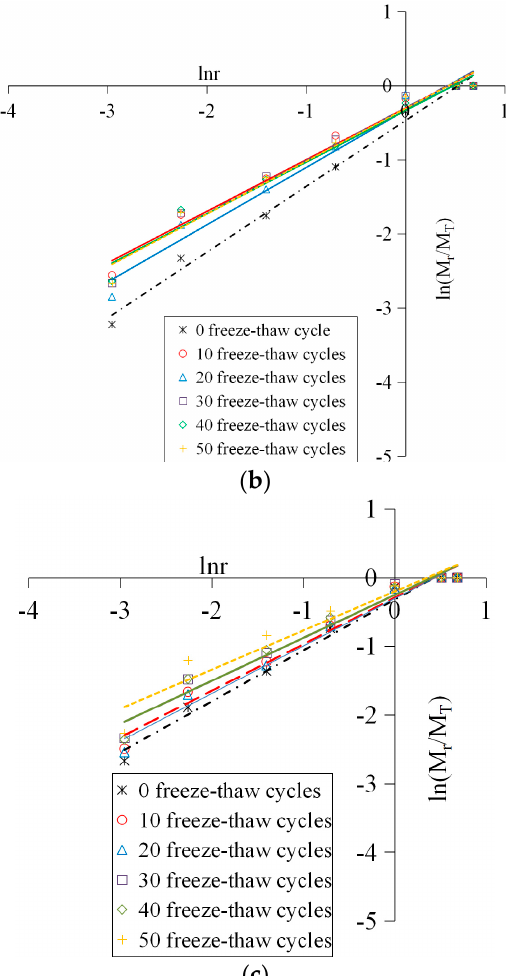
Figure 10. Logarithmic curves of concrete crushing blocks. ( a ) 5.4 m/s; ( b ) 8.8 m/s; ( c ) 11.3 m/s.